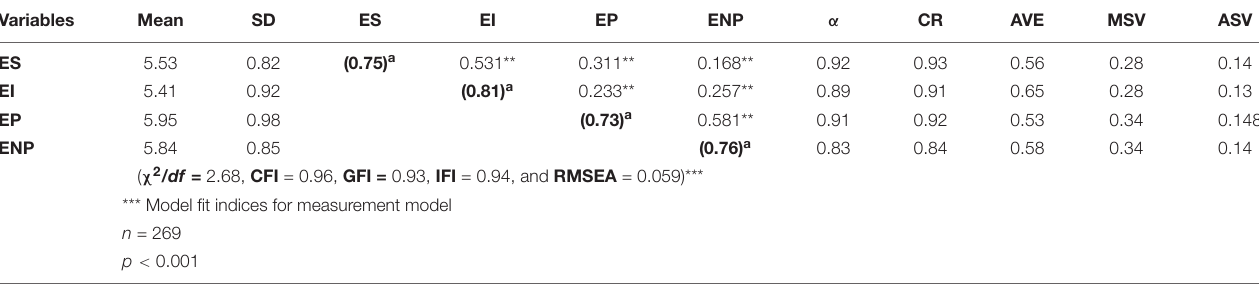
TABLE 2 | Correlations, validities, and reliabilities.